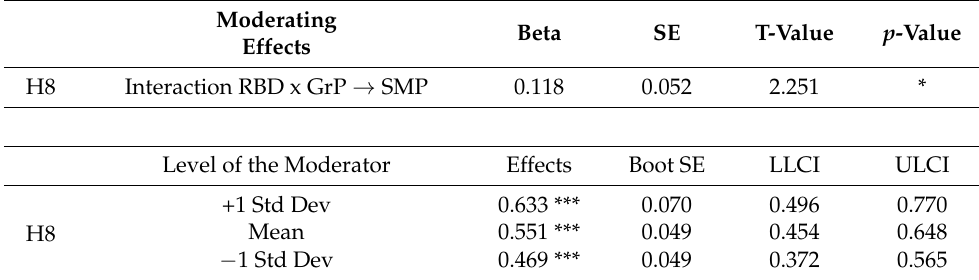
Table 6. Moderating Hypothesis